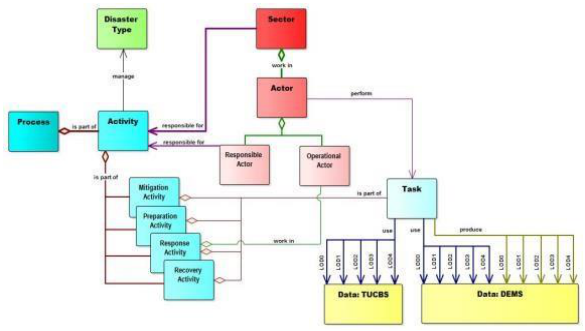
Figure 2: General conceptual approach for DEMS